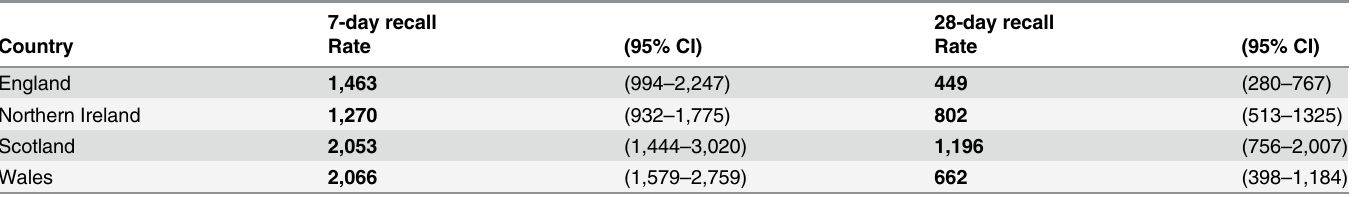
Table 3. Incidence rate of overall IID in the telephone survey by recall period and country. Estimates are standardised by age and sex according to the UK census population and they are adjusted taking into account different size of the populations in each UK country, prevalence of non-infectious diarrhoea in the population, proportion of time spent outside the UK, and number of interviews completed each